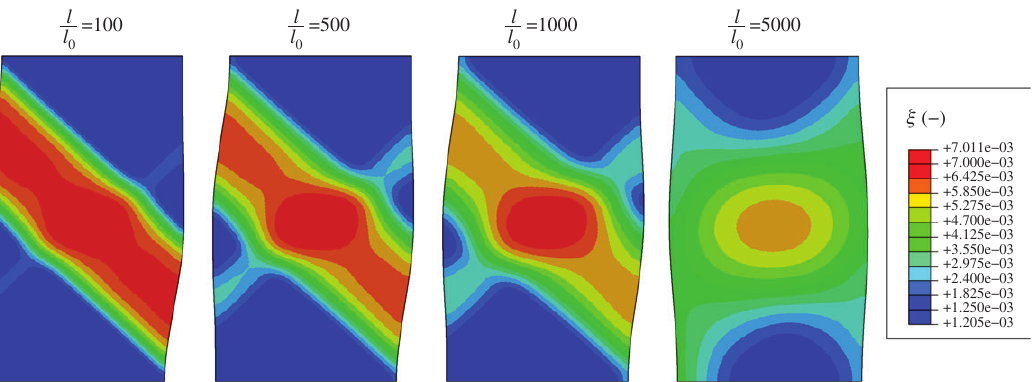
Figure 10 Sample S , length scale-dependent behavior: spatial distribution of free volume ξ at an applied compression strain | E 1 l different ratios of internal length l and external specimen size l l 0